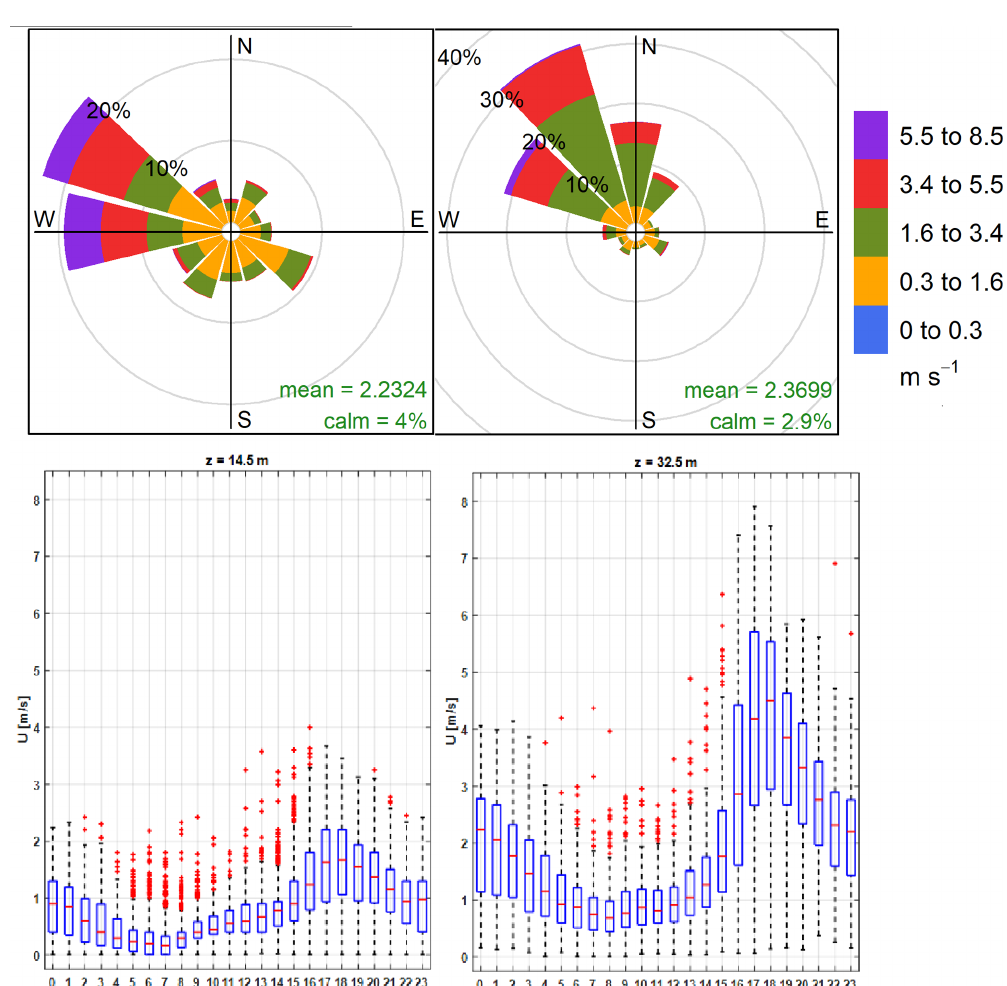
Figure 2. Wind pattern in the sampling location. (a) Predominant wind rose during the sampling period (July–September 2018). (b) Hourly profile of wind speed at 14.5m above the ground (August–December 2017). (c) Hourly profile of wind speed in sampling location at 32.5m over the ground level (December 2017–September 2018). ∗ Red points corresponding to the upper 10% of outliers.